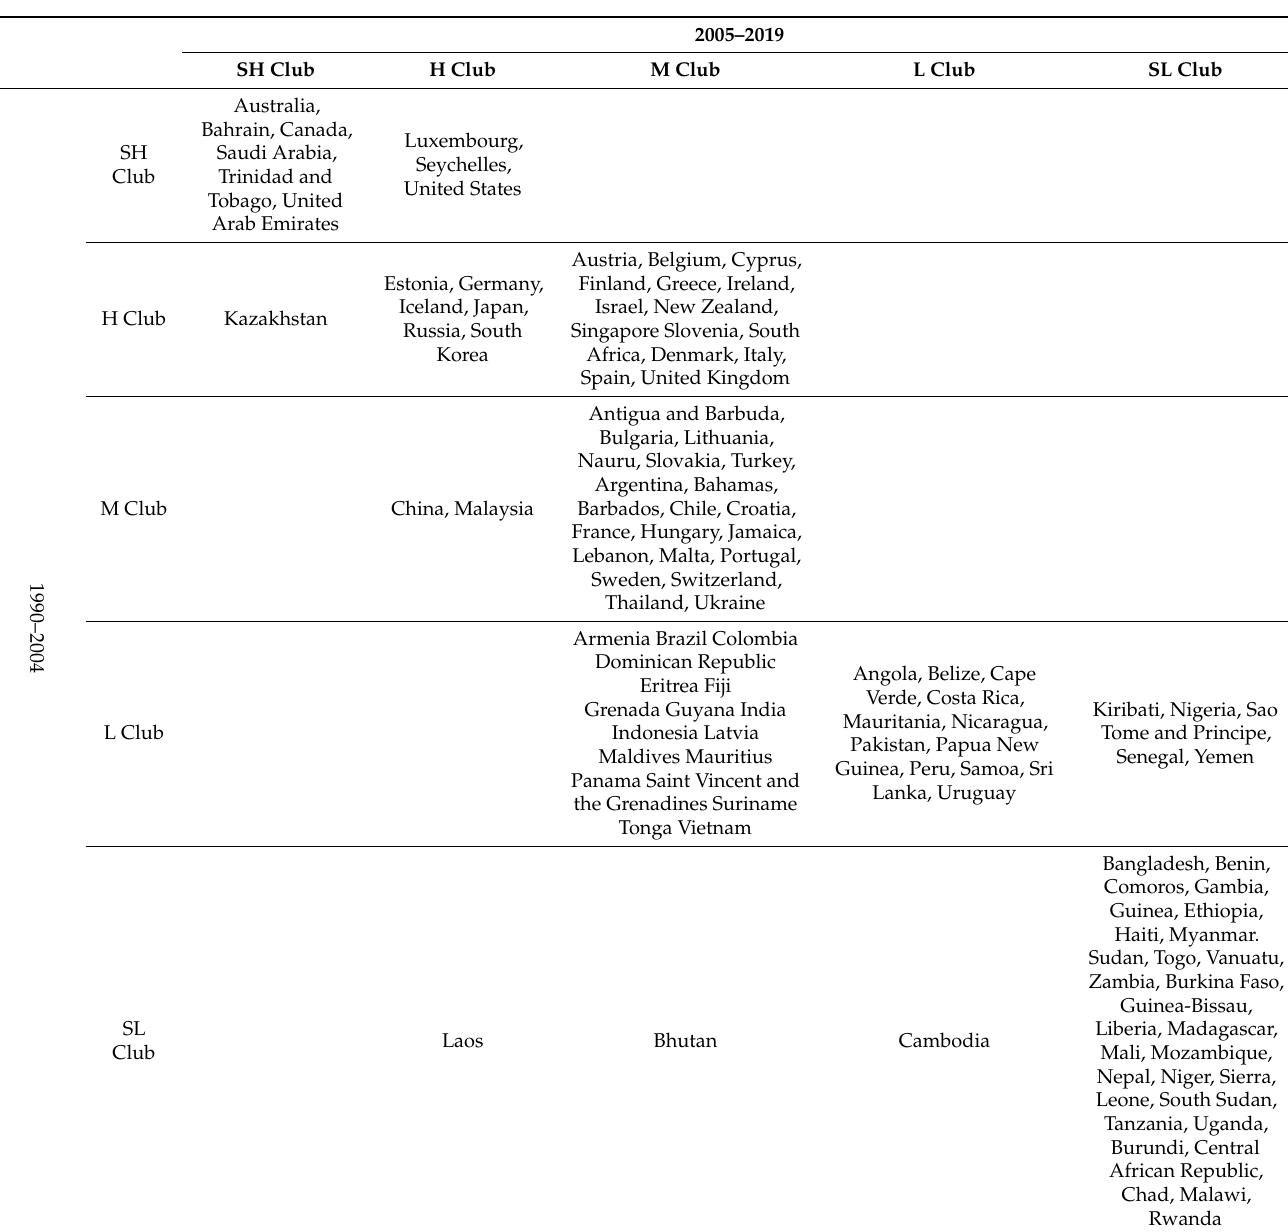
Table 4. Comparison of convergence club